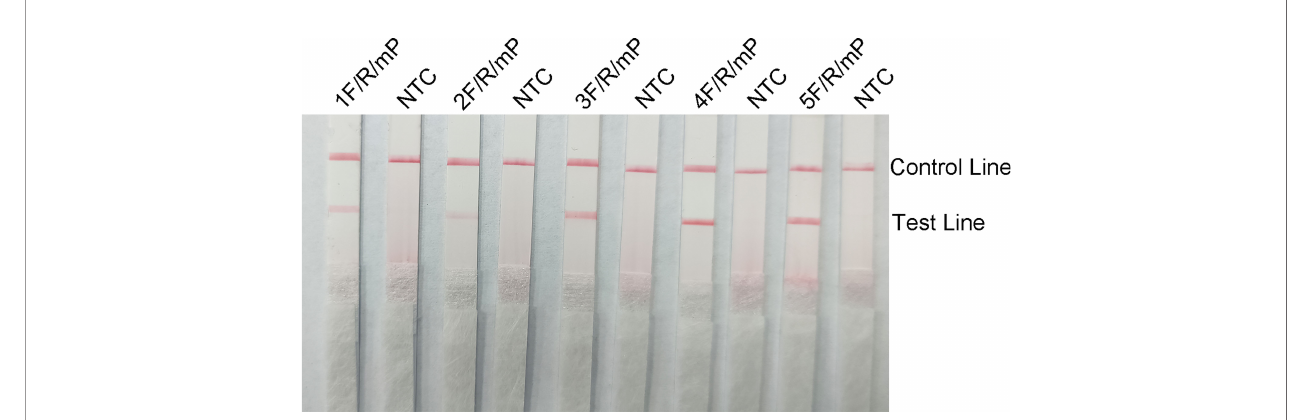
FIGURE 6 | The performance of the primer-probe sets was tested using the RPA-LFS system. The LFS results of the RPA ampli fi ed products are shown in the fi gure. The name of each primer-probe set is labeled above the corresponding strip. The NTC strip is the template-free control for the corresponding RPA reaction on the left strip. The positions of the test and control lines are marked on the right side of